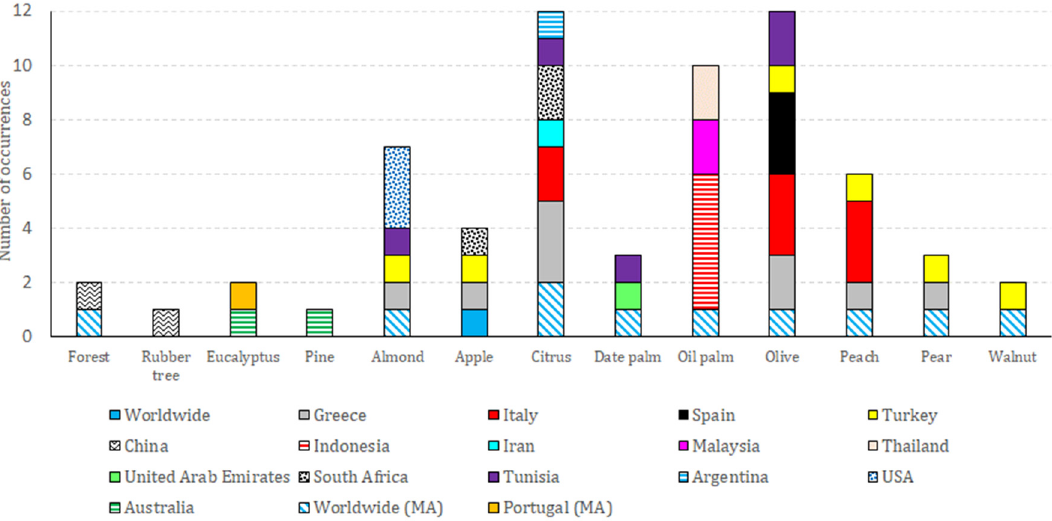
Figure 6. Tree type and geographical coverage are considered in case studies and mixed approaches. The “citrus” label encompasses lemon and orange, and the “peach” label includes peach and nectarine. MA refers to mixed approaches.